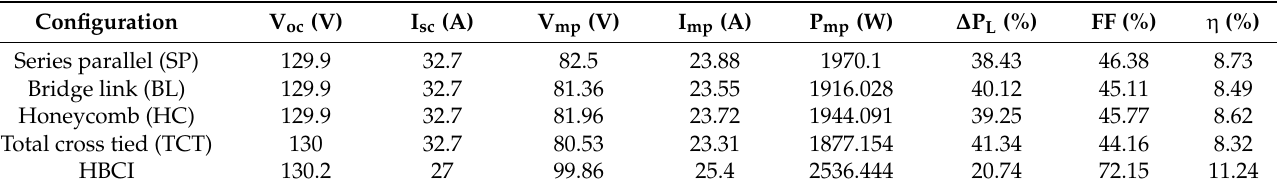
Table 3. Case 2: corner